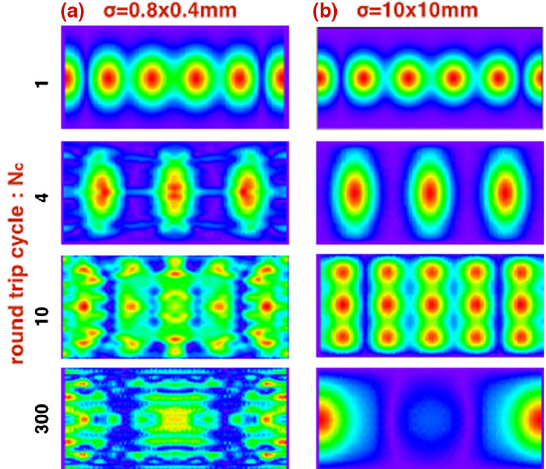
FIG. 24. Laser profiles on output mirror without hole, and with broad gain profile, at λ ¼ 20 μ m, for consecutive round trips N ¼ 17 (a), 18 (b) and 19 (c). in the cavity: N c